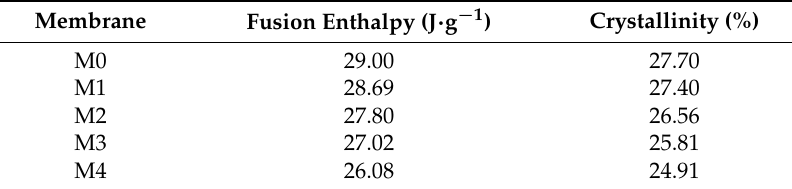
Figure 5. Influence of DBP/DOP ratio on the static water contact angle.